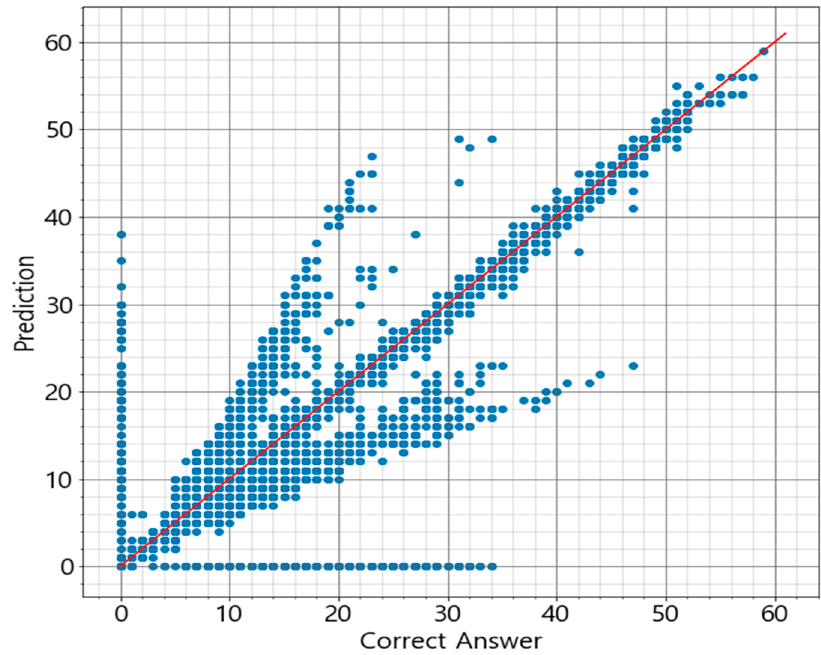
Figure 18. Prediction of sap amount based on SVM.